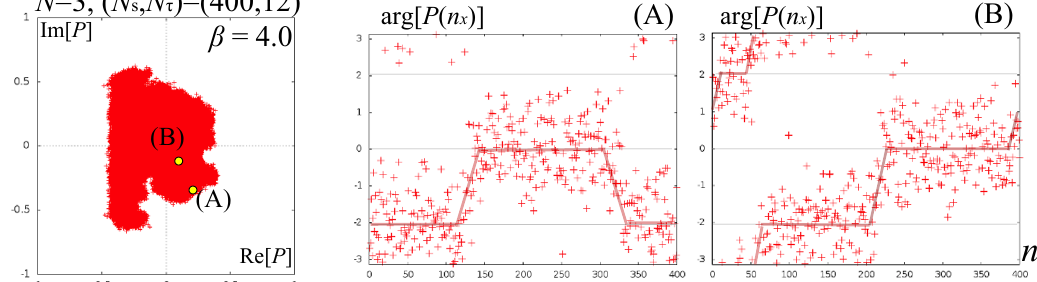
Figure 10 . (Left): distribution plot of the Polyakov loop for N = 3, (cid:12) = 4 : 0 with ( N s ; N (cid:28) ) = (400 ; 12) for Z N -TBC with the two con(cid:12)gurations (A)(B) pointed. (Center)(Right): position depen- dences of arg[ P ( n x )] on 1 (cid:20) n x (cid:20) N s for the two selected con(cid:12)gurations (A)(B) in the distribution plot. We show the three vacua by gray lines and the speculated vacuum transitions by red lines. (A) corresponds to a bion while (B) to three fractional